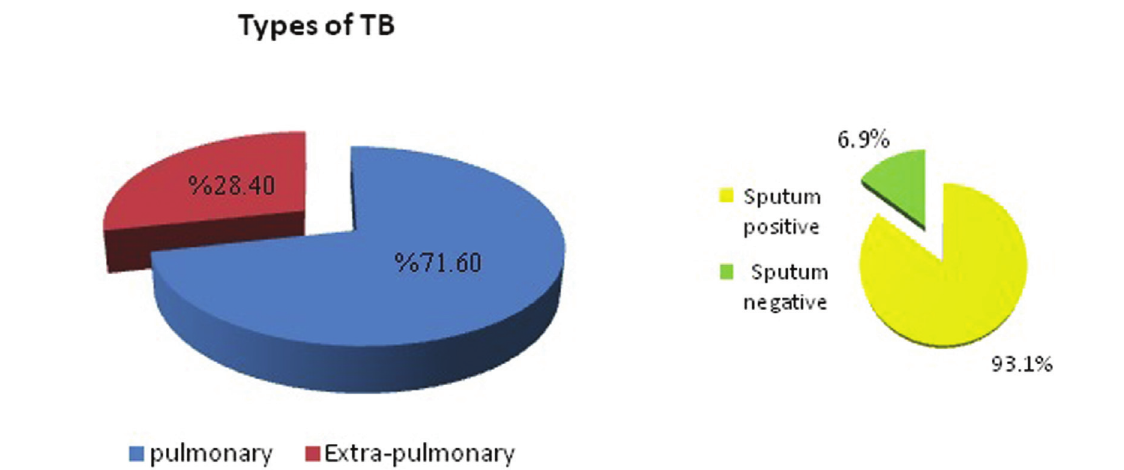
Distribution of patients according to the type of TB ( N = 183). TB, tuberculosis.